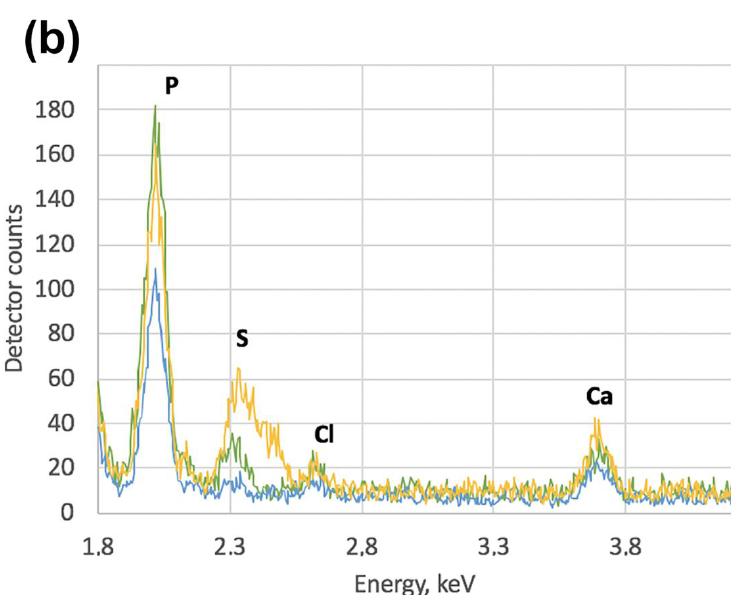
Figure 3. EDX spectra of P. aeruginosa control cells, 15 and 30 min after phiKZ infection. ( a ) Colored outlines mark the areas of bacteria subjected for EDX analysis. Bars – 0.5 um.; ( b ) Superimposed EDX spectra from the selected areas, marked in ( a ), normalized to the C peak. Peaks are labeled as follows: P — phosphorus; S — sulfur; Cl — chloride; Ca — calcium. After 30 min of infection, the pseudo-nuclei maturated — they became almost spherical and moved closer to the center of the cell (Figure 1, 3 0′ , blue arrowheads), similar to prior observations [15,24]. A single pseudo-nucleus was observed in ~88% of infected cells, while the two-compartment pseudo-nucleus — in ~12% of infected cells, in concordance with previous studies [24]. At the same time, in some cells, the RC remained. The newly synthesized empty and filled phage capsids were detected both close to the surface of the pseudo-nucleus and to the cell wall (Figure 1, red arrows; Figure S1). The average diameter of an empty capsid was 85 nm, a filled one — 100 nm, the latter somewhat smaller than the size of a phiKZ mature capsid, which is 145 nm [2,8,29], suggesting that the final maturation of the phage capsids was still ahead. The bacterial nucleoid became less obvious at the periphery of the cell by the 40th min after the start of the infection, which could relate to the